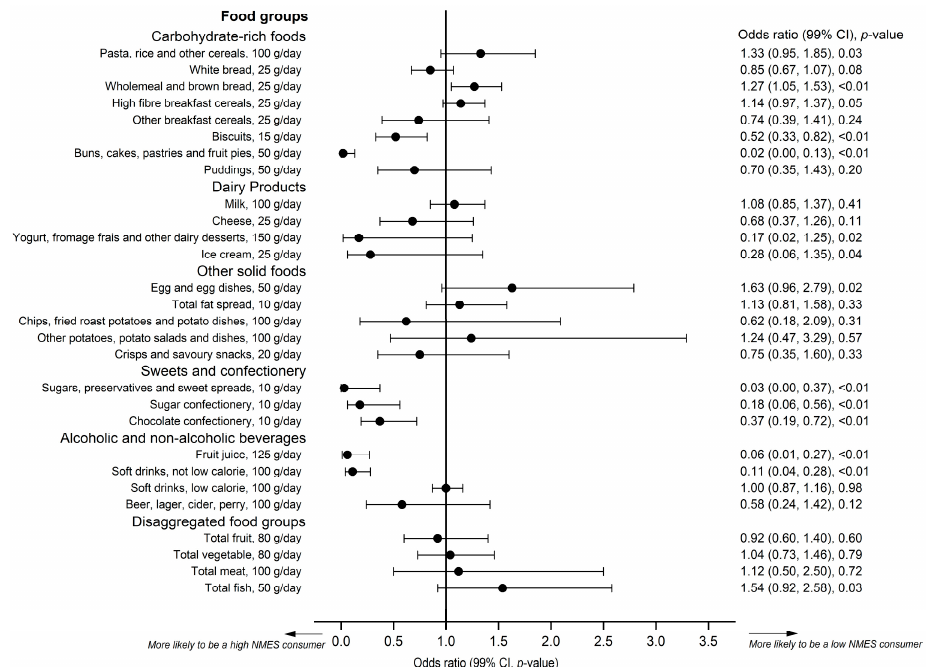
Figure 3. The odds (99% CI, p -value) of adolescents aged 11 to 18 years being categorised as consuming < 10% NMES of total energy with increasing consumption of various foods by portion (g / day) in the National Diet and Nutrition Survey.